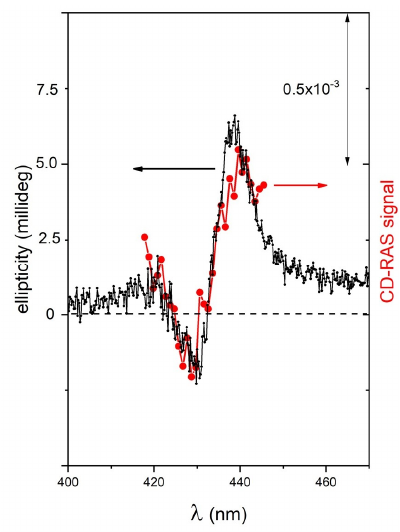
Figure 6. CD-RAS experimental spectrum for sample B (red curve), compared with the ellipticity spectrum measured for the same sample by a commercial spectrometer for circular dichroism (black curve, left vertical axis). The double-arrow reported in the figure is the unit for the CD-RAS data. The CD-RAS spectrum was corrected by subtracting the optical background of the glass cuvette containing an achiral solution (measured in the same experimental conditions). Here, sample B is a